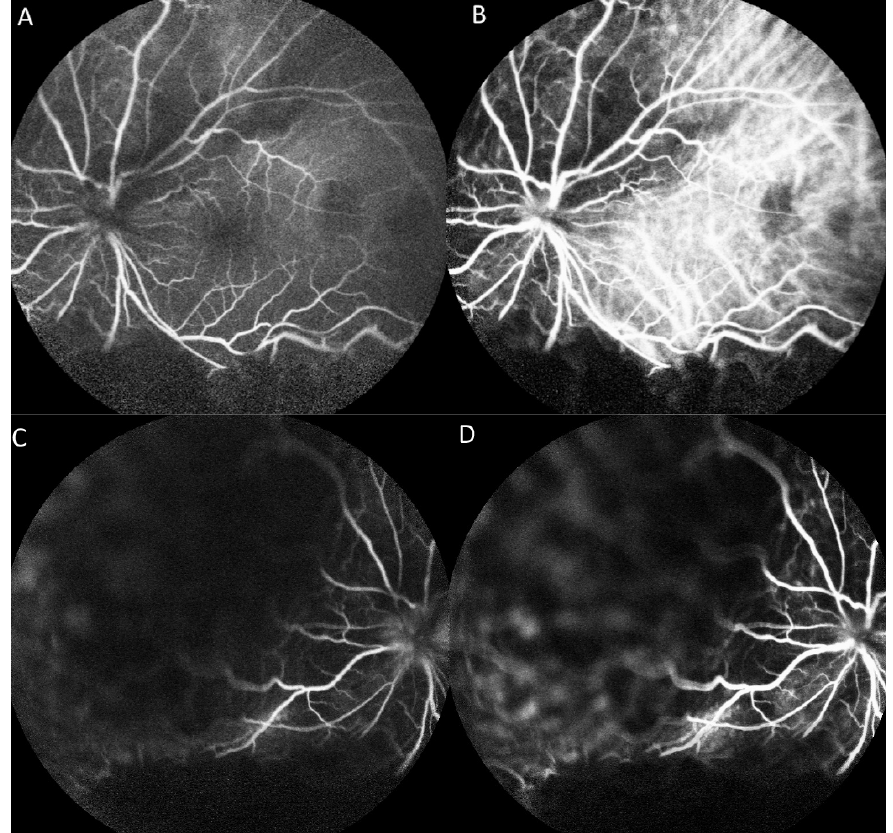
Figure 3. Fluorescence angiography (FA) and indocyanine green angiography (ICG) of the left eye. ( A ) FA shows hypofluorescence in the superior and inferior regions and two hypofluorescent points in the temporal region of the fovea in the early phase. ( B ) ICG shows a hypofluorescent region corresponding with that on FA in the early phase. ( C ) FA shows hypofluorescence in the superior and inferior regions in the late phase. ( D ) ICG shows hypofluorescent regions corresponding with those on FA in the late phase.